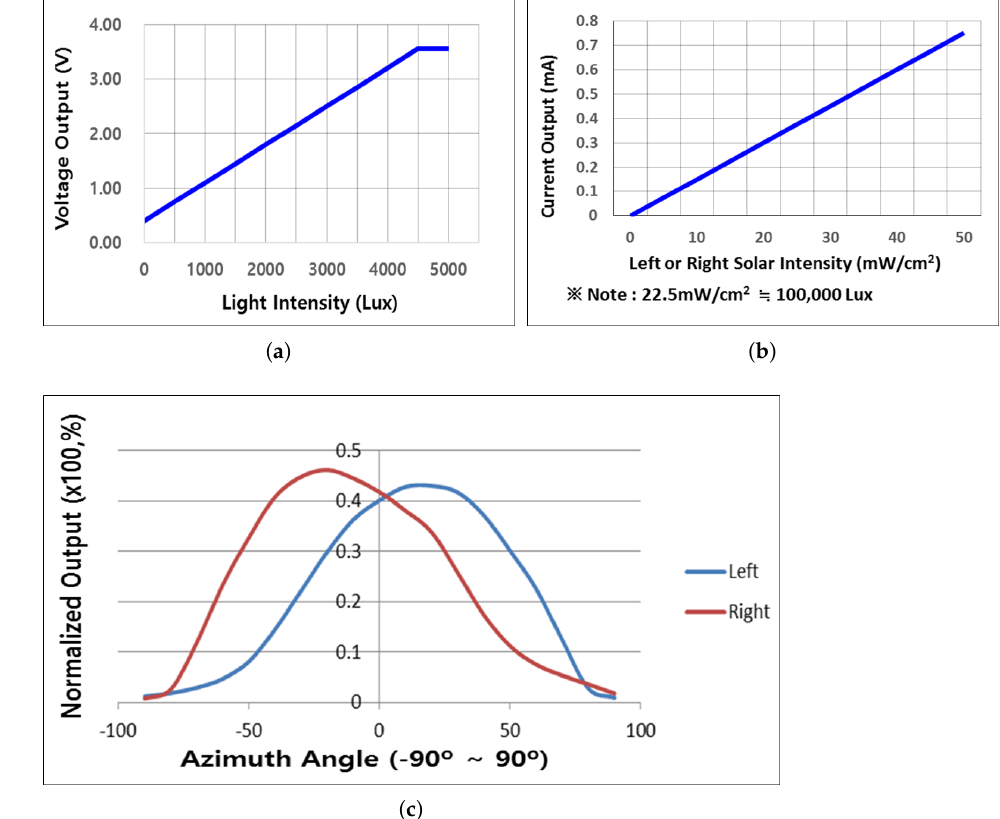
Figure 8. Illumination for dual light sensor: ( a ) twilight sensor voltage output vs. light level, ( b ) solar sensor current output vs. light level, and ( c ) relative solar output for dual light